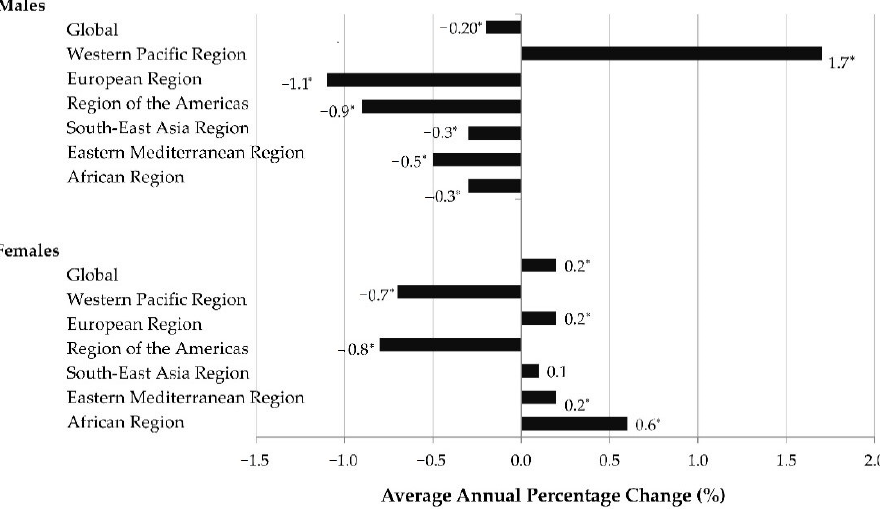
Figure 2. Global mortality trends of lip and oral cavity cancer, by regions and by sexes, in the period 1990–2019: a joinpoint regression analysis. * Statistically significant, p < 0.05.